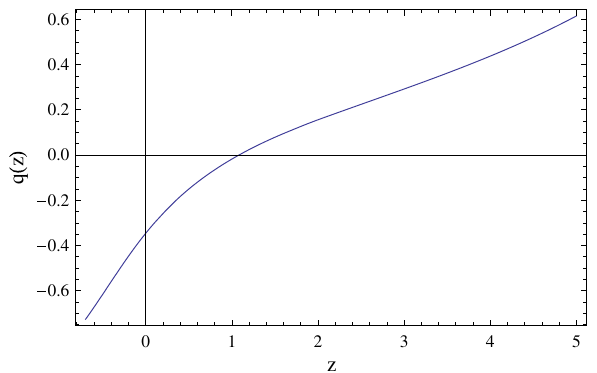
Fig. 3 Variationof q ( z ) withthevariationof z (ModelI)byconsidering the best fit values w 0 = − 0 . 737 ,w 1 = 0 . 173